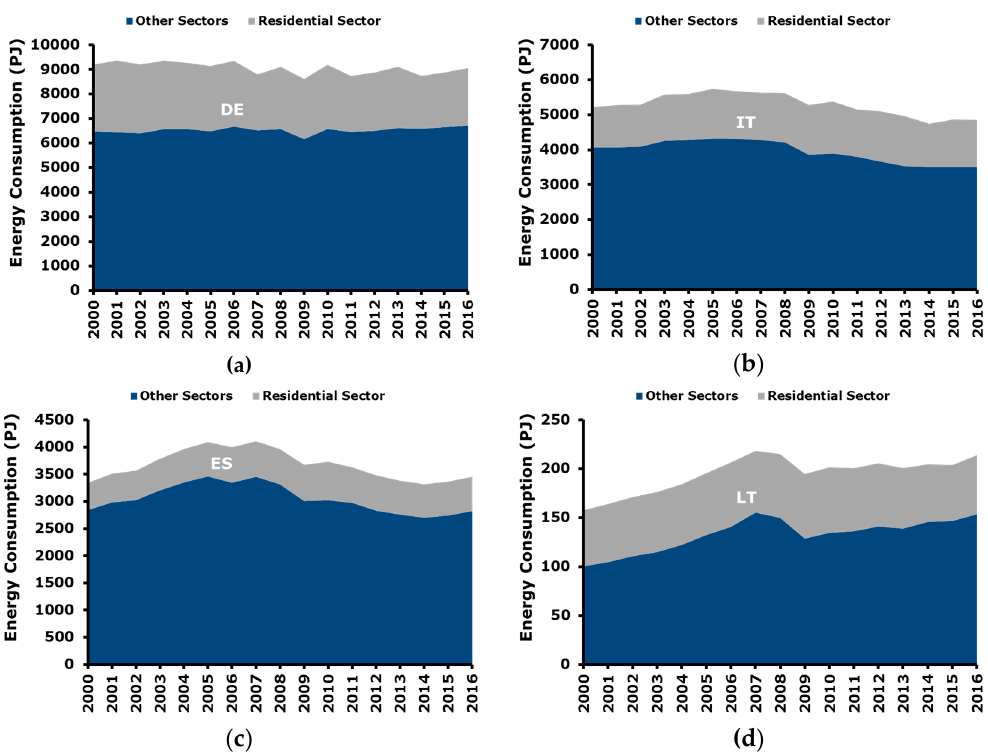
Figure 1. Evolution of energy consumption in the target countries: ( a ) Germany; ( b ) Italy; ( c ) Spain; ( d ) Lithuania. Other sectors group service, industry, transportation, and electricity generation sectors.